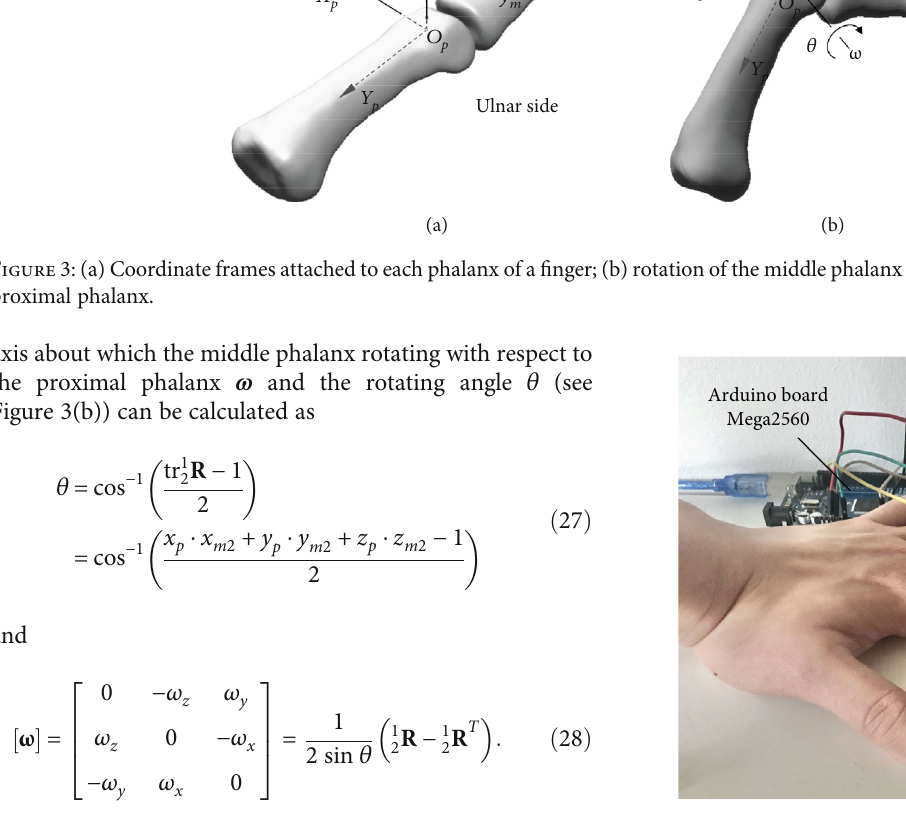
Figure 4: Gyroscope sensor in in vivo test of joint axis of PIP joint in an index fi